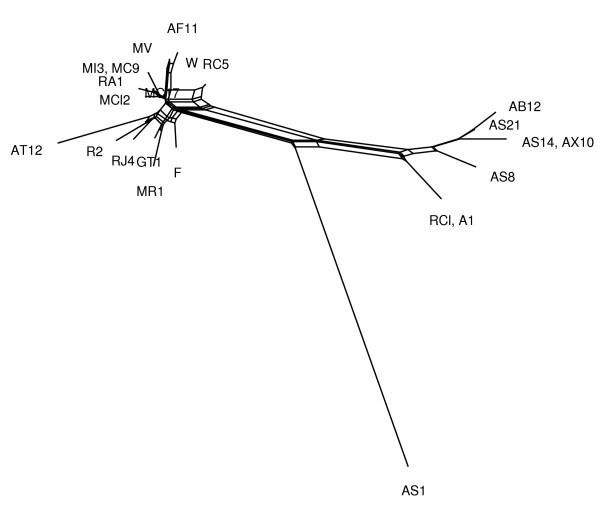
The N-Net network for the Rubber data set.